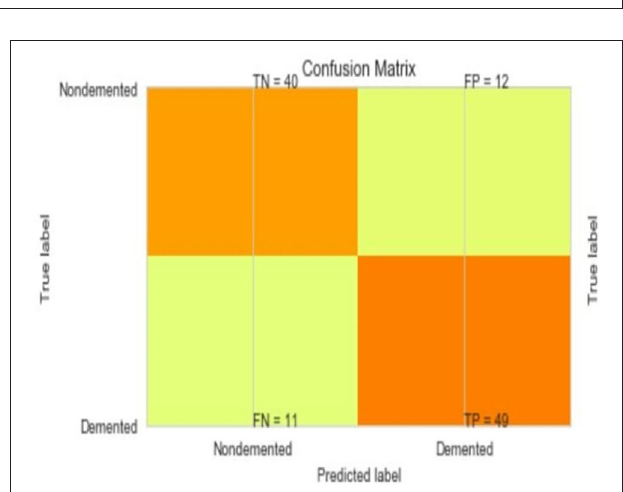
FIGURE 8 | Confusion matrix for decision